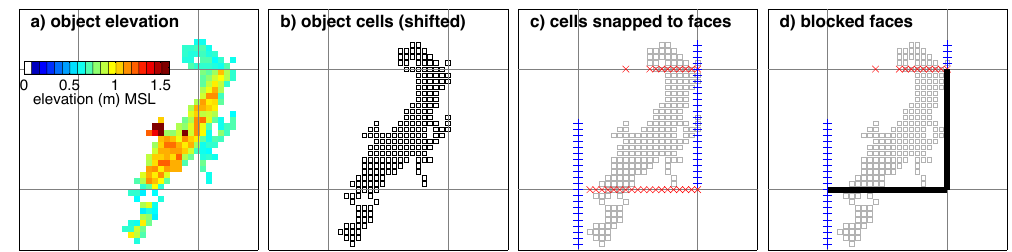
Figure 4. Blocking caused by a small object. The red × and blue + represent fine-grid blocking cells (gray (cid:3) ) snapped to the coarse-grid faces G y and G x ; black lines are the resulting blocked coarse-grid faces. Here and throughout this paper δ = 1 is used for defining blocking. The object cells in (b) are slightly shifted from (a) as discussed in the text to better align with coarse